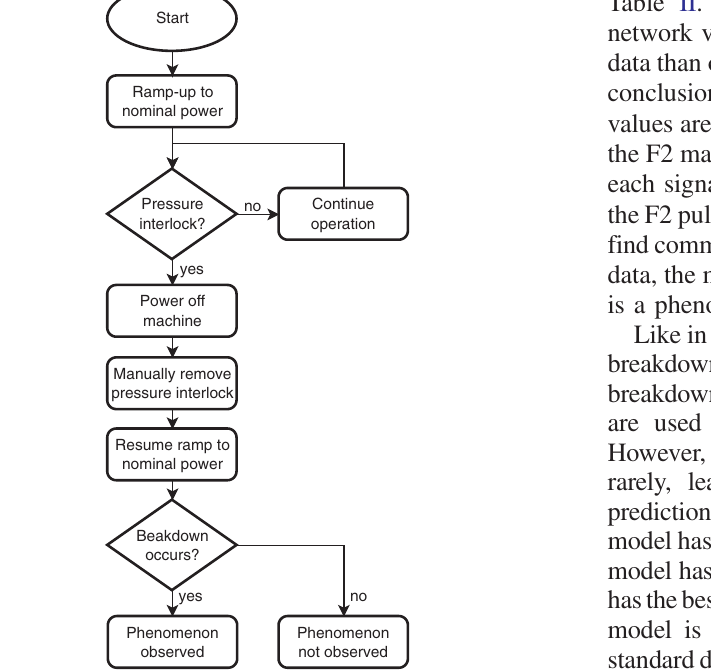
FIG. 13. Flowchart showing the procedure of the experiment. The pressure interlock was set to 10% above a nominal pressure. The Faraday cup signals and the reflected traveling waves were used to detect the